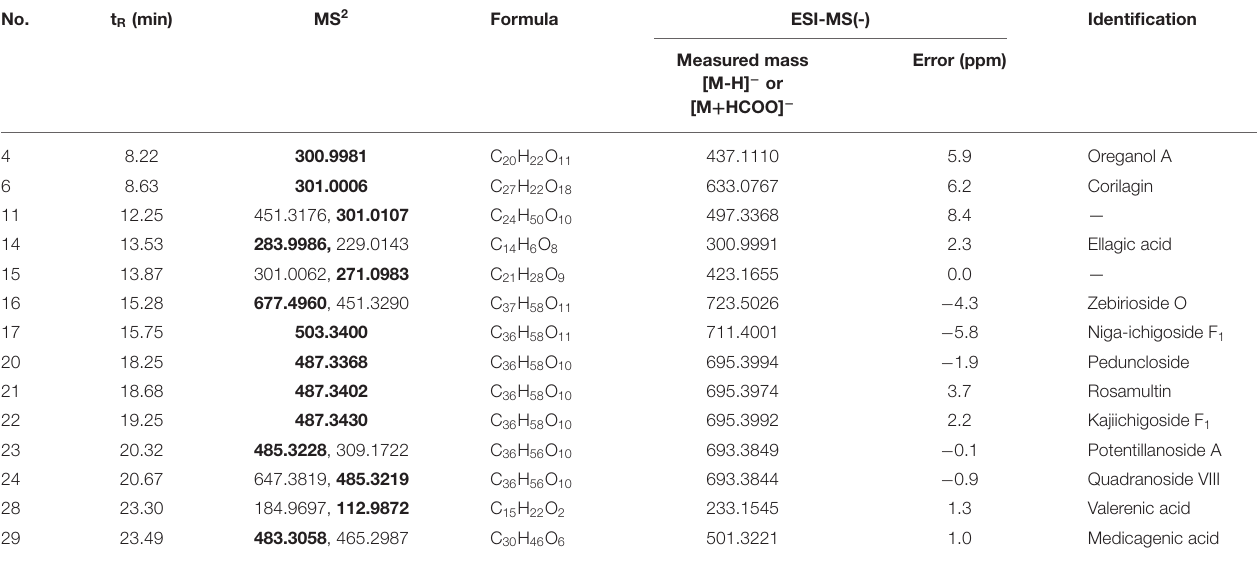
TABLE 1 | Chromatographic and mass characteristics of MMP-2 binding